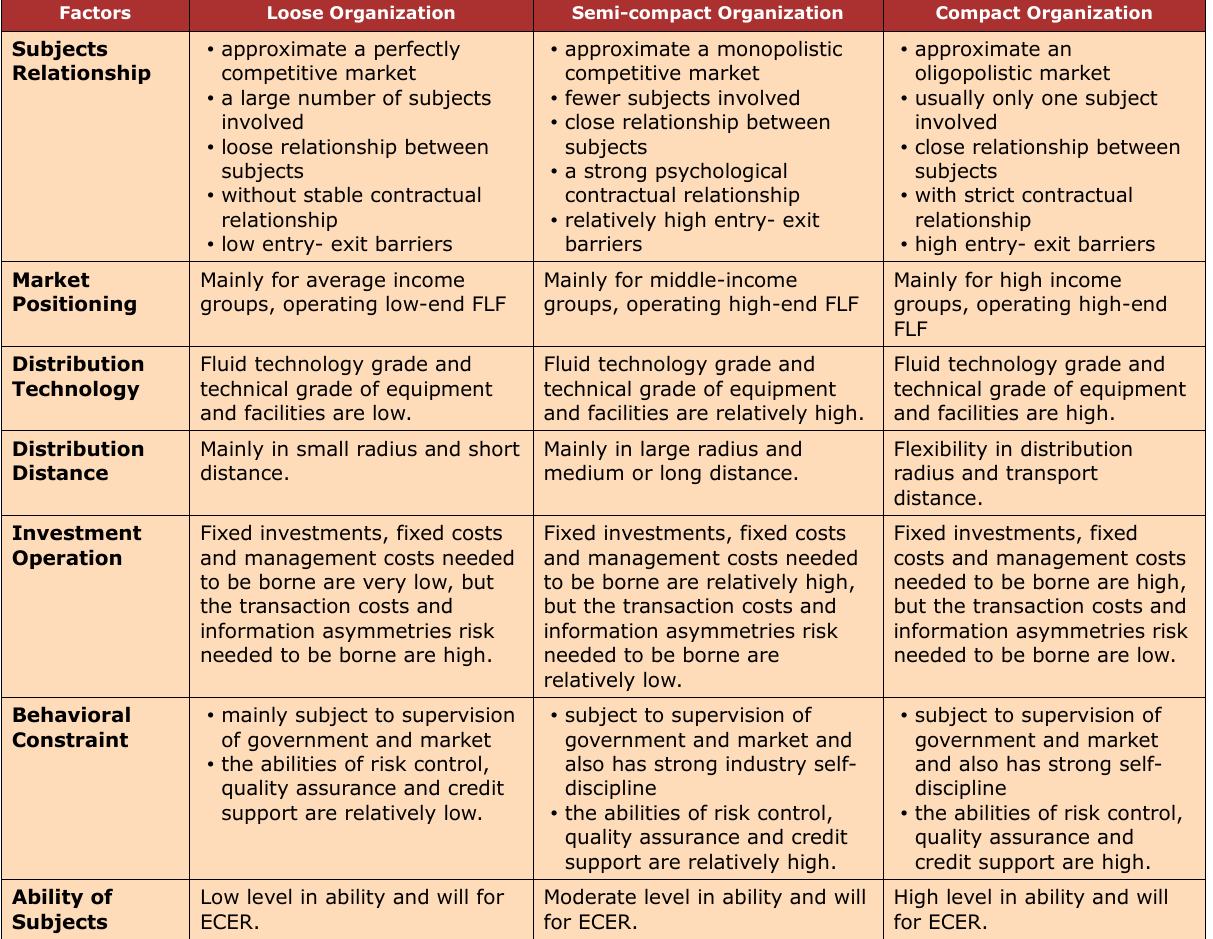
Table 1. Characteristics of three types of FLF supply chain